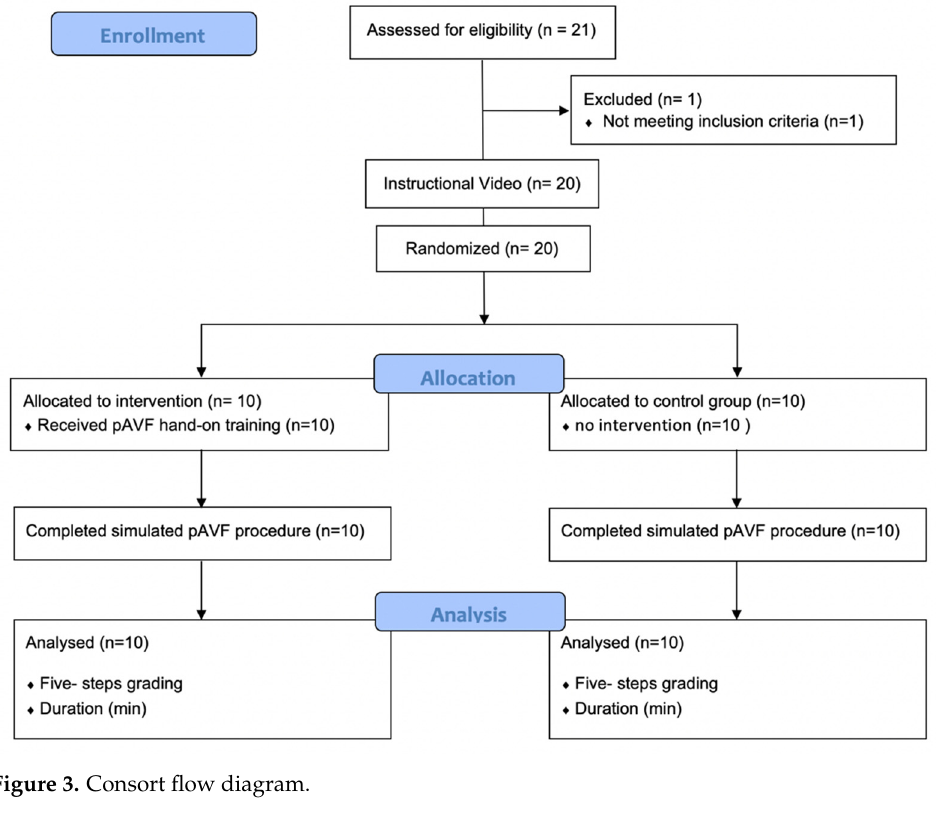
Figure 3. Consort flow diagram.